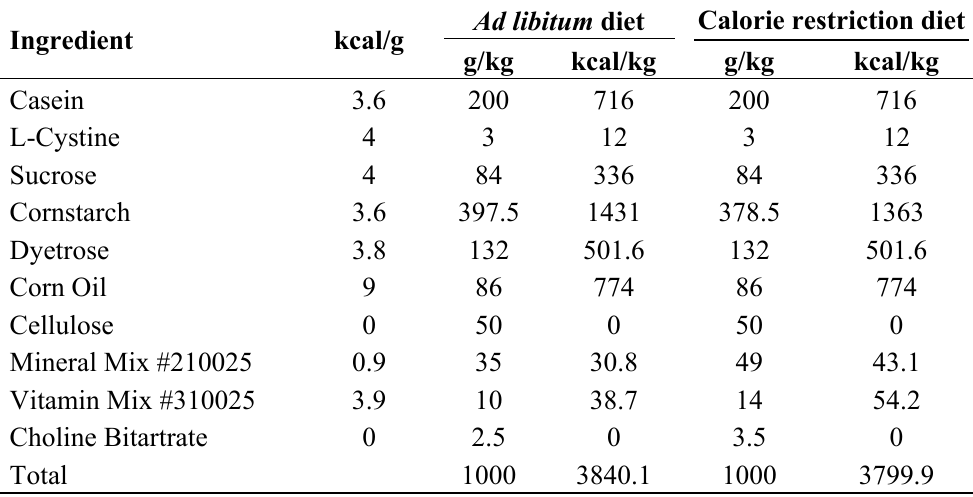
Table 1. Ingredients of experimental